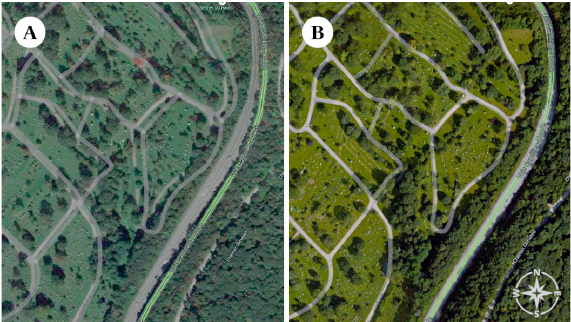
Fig. 4. Relief displacement in Mount Royal, the city of Montreal, (A) before, and (B) after correction. This location is marked by a green square in Fig.